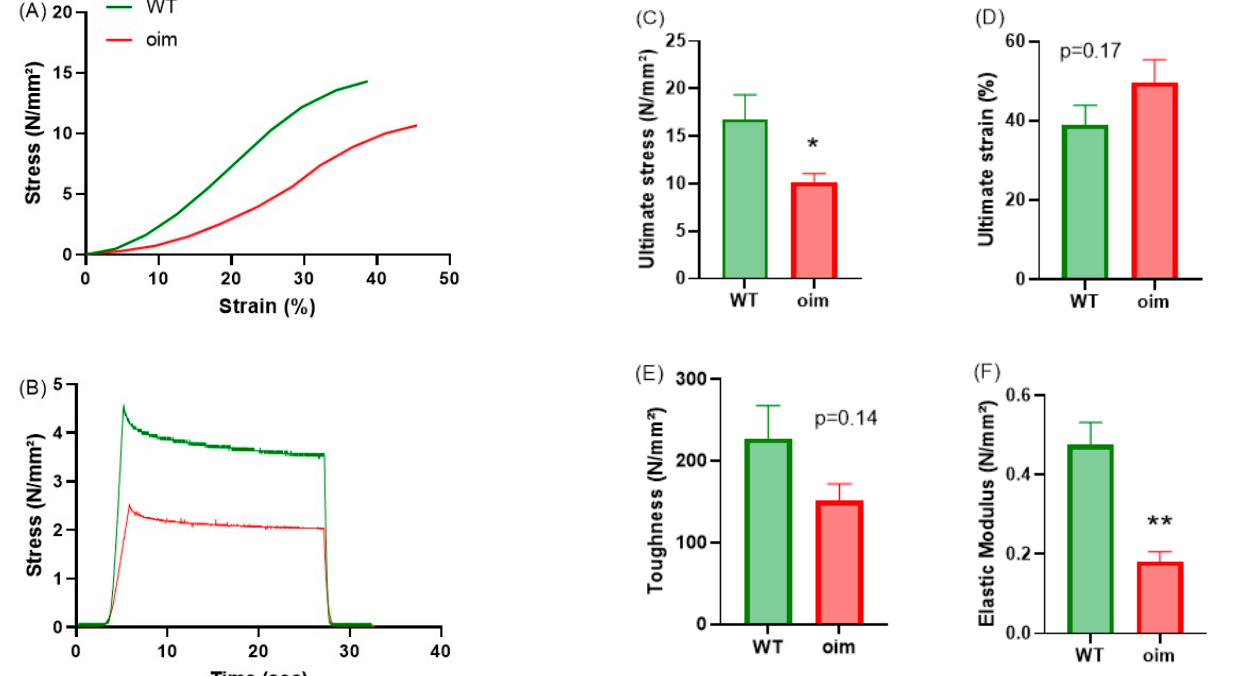
decreased, the work to fracture (Figure 3F) was also significantly lower, by − 84.4%, than in WT mice ( p = 0.0001).